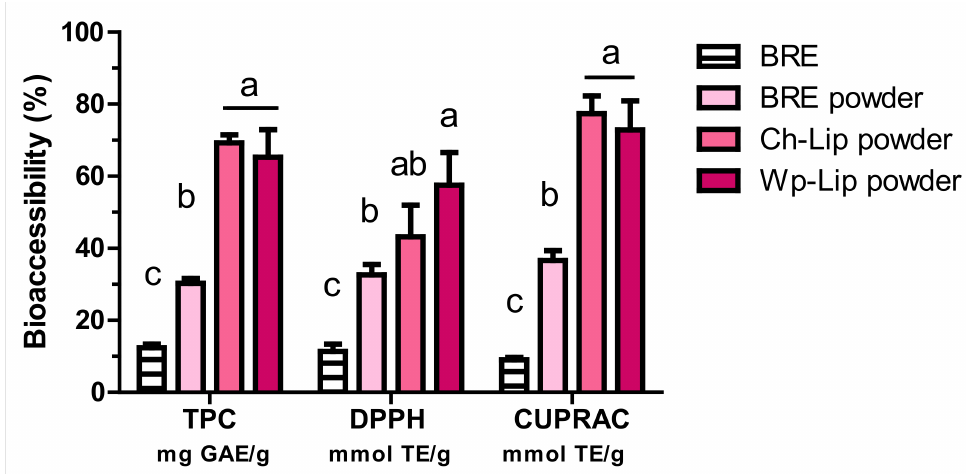
Figure 3. Total (poly)phenolic content (TPC) and total antioxidant capacity (DPPH and CUPRAC assays) (% of TPC and TAC in initial extract) in the bioaccessible fraction of freeze-dried (BRE), spray-dried (BRE powder), and chitosan- and whey protein-coated liposome powdered (Ch-Lip and Wp-Lip) BRE after in vitro gastrointestinal digestion. Values represent means ± SD ( n = 6). Different superscript letters indicate statistically significant differences ( p <